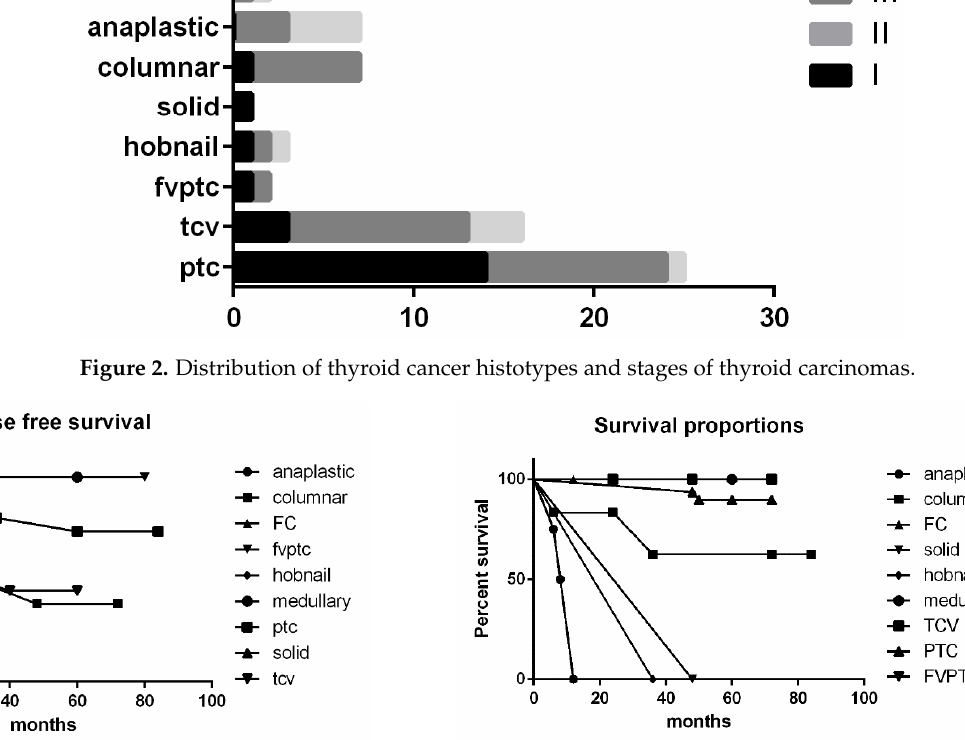
Figure 2. Distribution of thyroid cancer histotypes and stages of thyroid carcinomas.